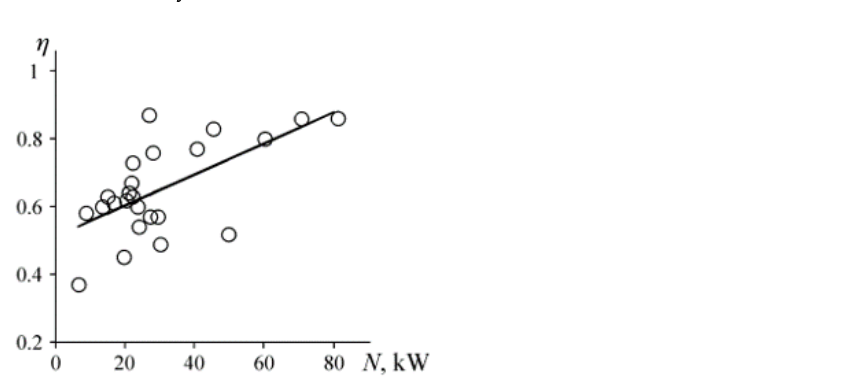
Figure 14. The efficiency of hydraulic hammering vs. power